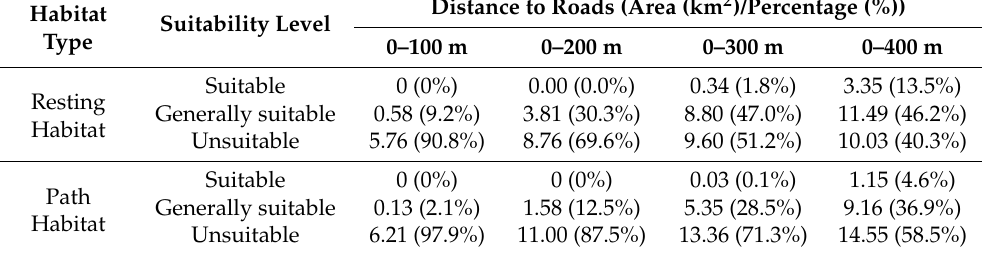
Table 1. Distribution of resting and path habitats with different suitability levels in different road- side